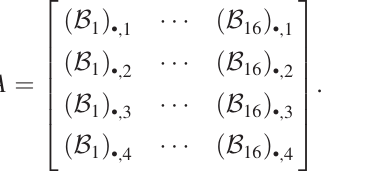
and ½ R can be x (cid:4) y (cid:4)